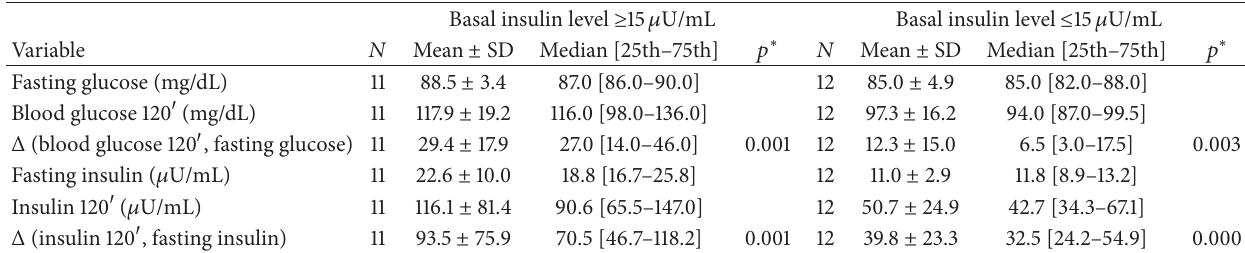
Table 2: Baseline values and changes by baseline insulin level.